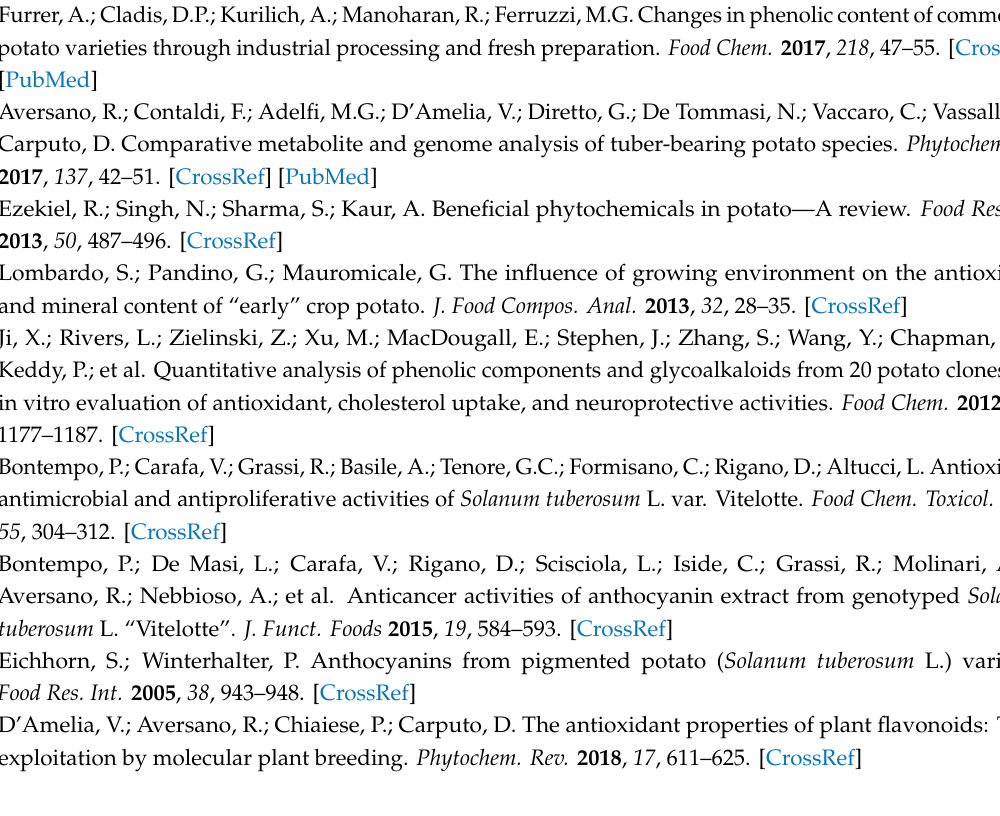
Supplementary Materials: The following are available online. Figure S1: PAE from S. tuberosum varieties inhibited hematological cancer cell proliferation. Figure S2: Tree diagram showing the genetic distances, calculated using SSR loci, between the four pigmented varieties and 22 commercial varieties of S. tuberosum . Figure S3: Tuber phenotype of the pigmented potato varieties used in this study. Table S1: Microsatellite alleles detected at SSR loci in the four pigmented potato varieties in